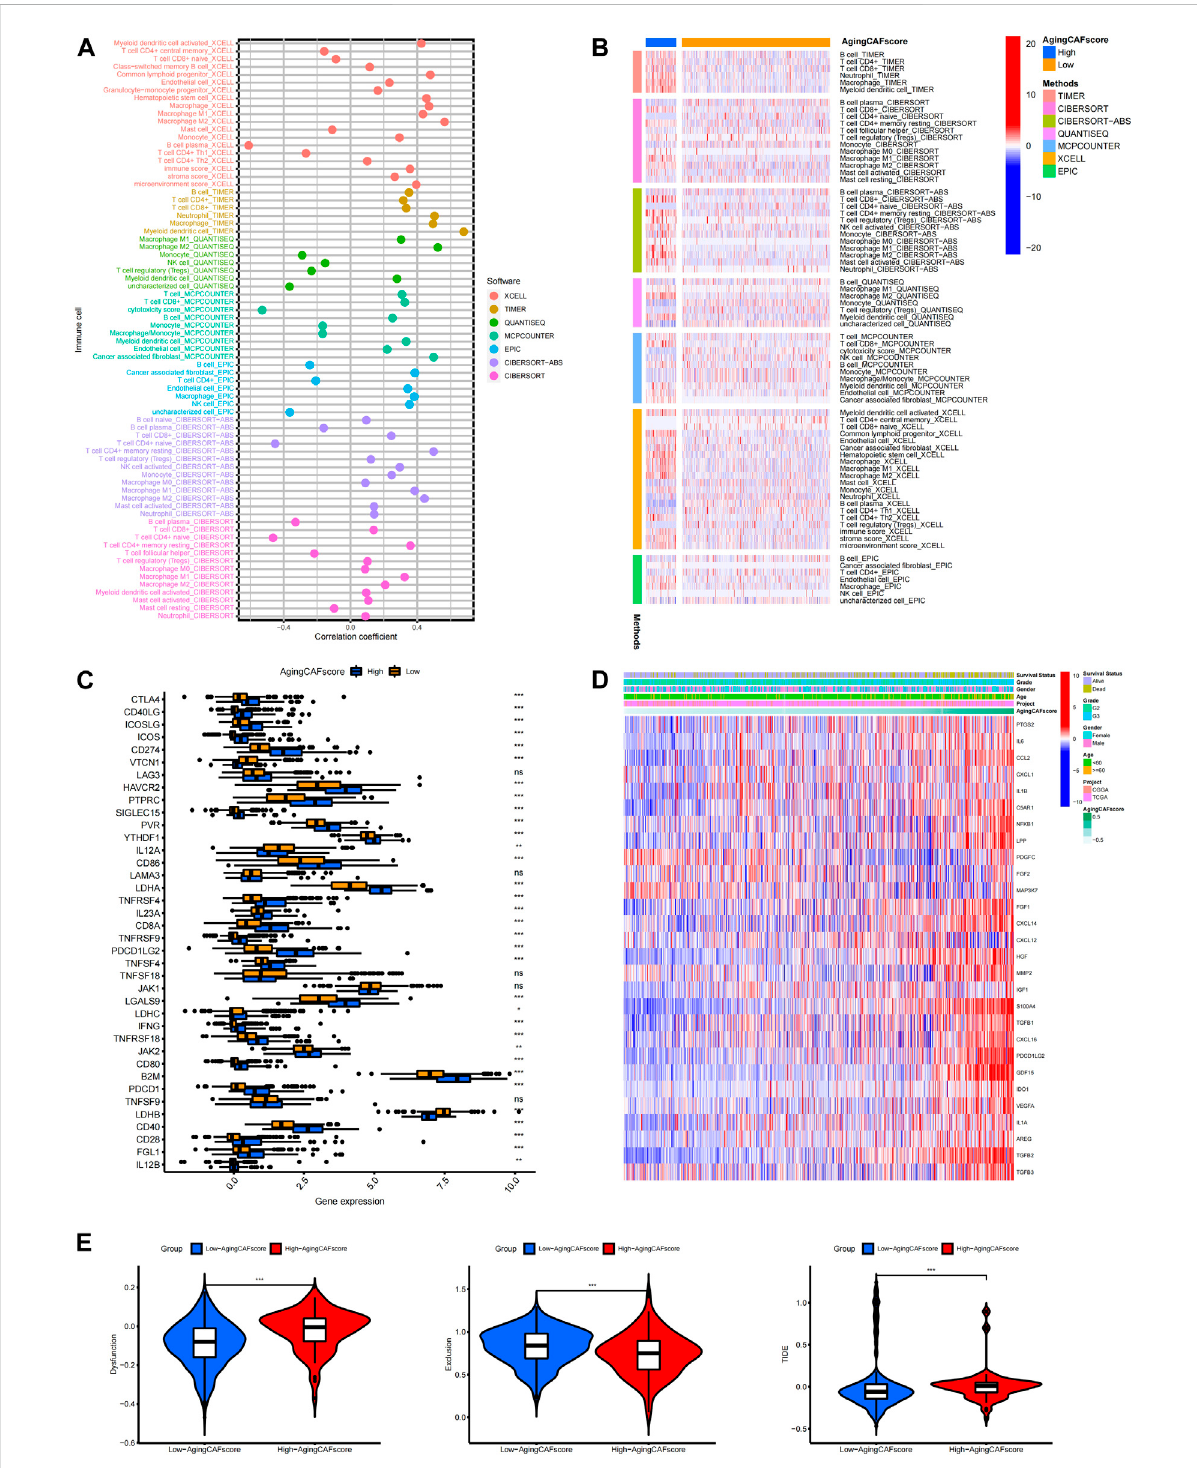
FIGURE 6 Exploration of the correlation between the aging CAF score and TME. (A) Correlation between the abundance of essential cells in the TME and aging CAF score. The cell types with p -values less than 0.05 were presented. (B) Heatmap showing the comparisons of the abundance of essential cellsintheTMEbetweenlow-andhigh-agingCAFscoregroups.Thecelltypeswith p -valueslessthan0.05werepresented. (C) Comparisonsofthe expressionlevelsofimmunecheckpointsbetweenthelow-andhigh-agingCAFscoregroups. (D) Expressionpatternsofcytokinessecretedby CAFs with increasing aging CAF scores. (E) Comparisons of TIDE-related scores between the two groups. * means p < 0.05, ** means p < 0.01, and ***means p < 0.001. CAF, cancer-associated fi broblast; TME, tumor microenvironment; TIDE, Tumor Immune Dysfunction and